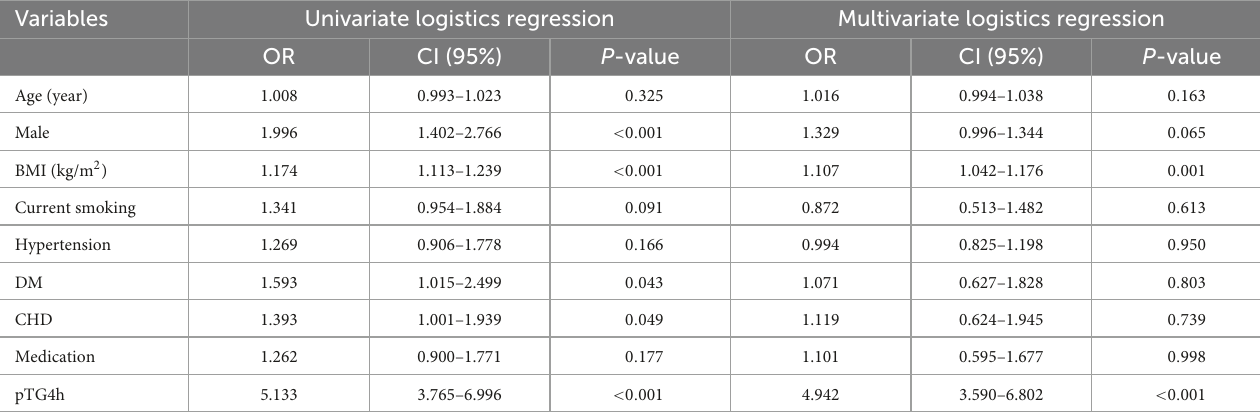
TABLE 2 Univariate and multivariate logistic regression analyses.